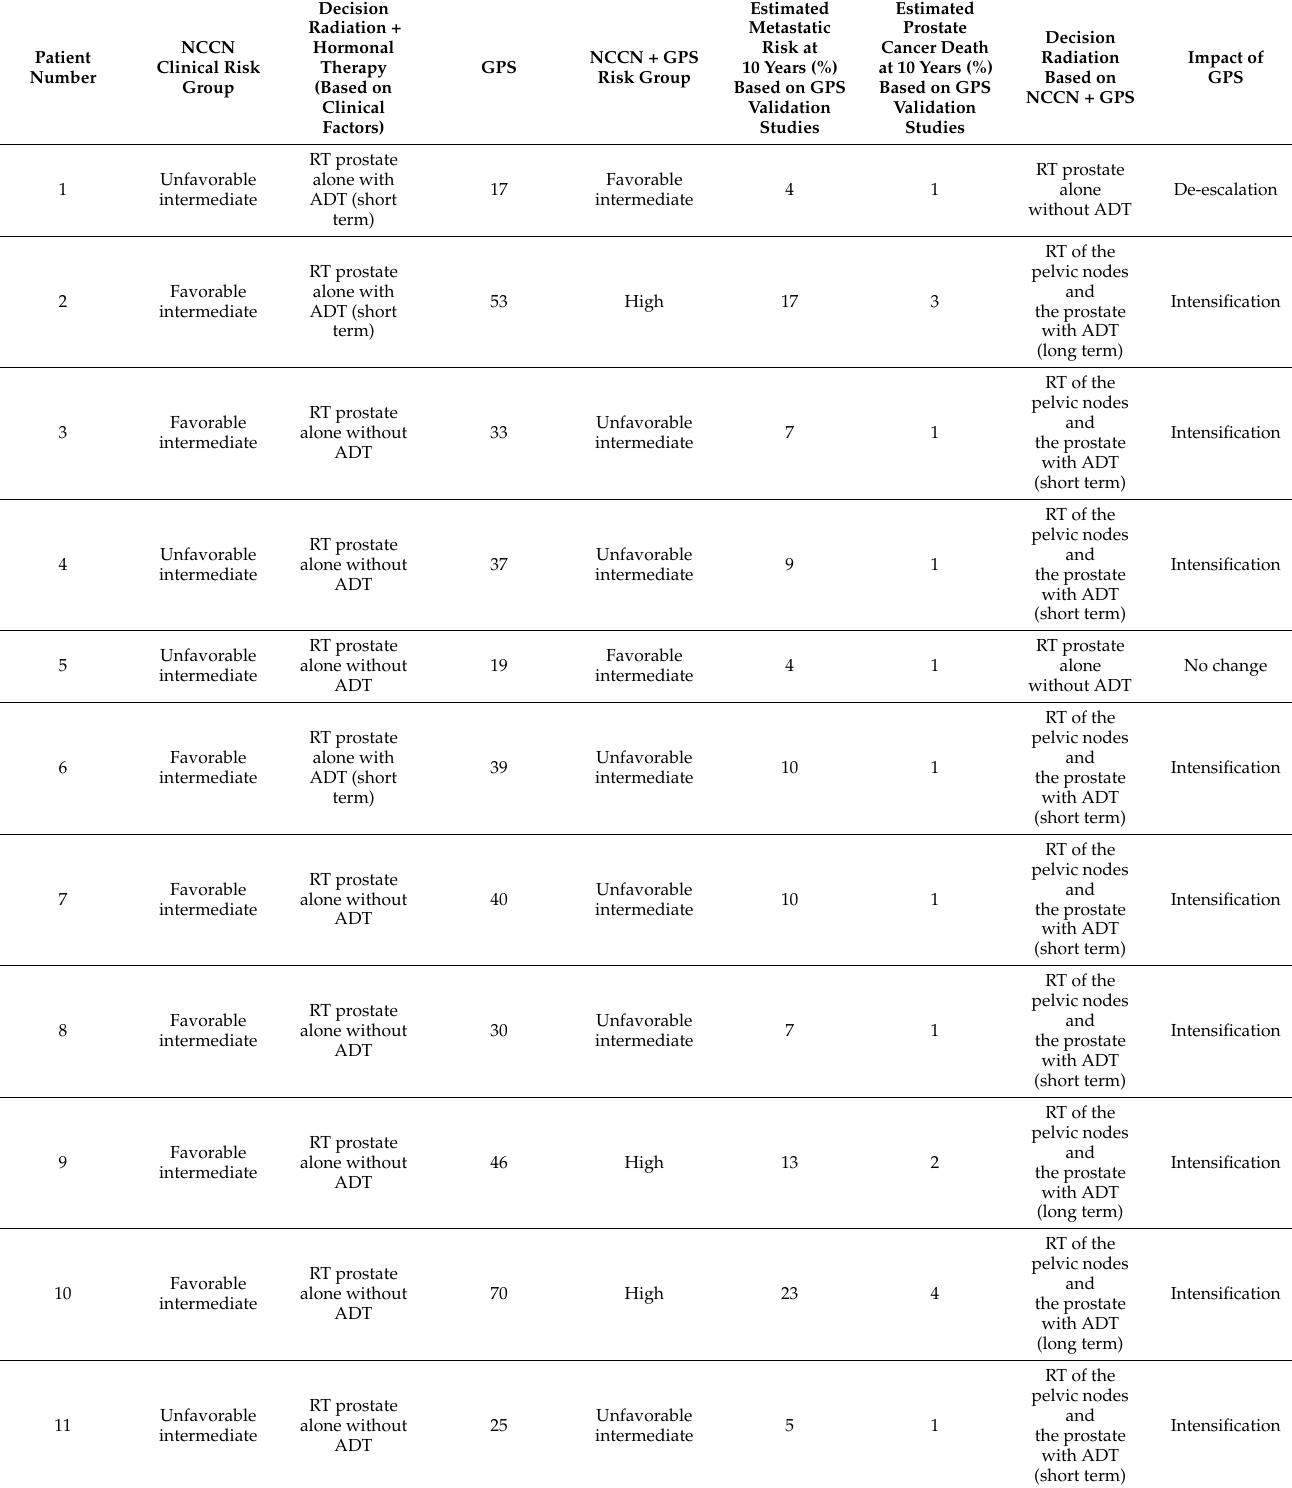
Table 2. Potential impact of GPS on treatment